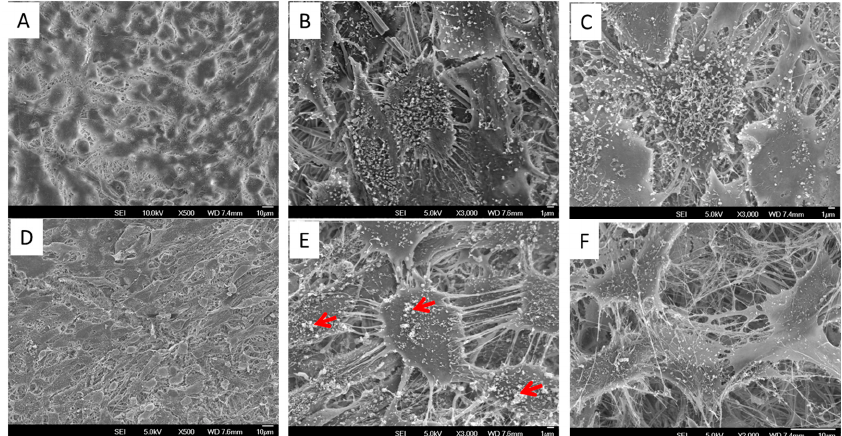
Figure 5. SEM micrographs showing mBMSCs morphologies cultured on PLLA and ECM/PLLA NF for 14 days. ( A ) PLLA (at low mag); ( B ) PLLA (at high mag); ( C ) PLLA (matrix deposition); and ( D ) ECM/PLLA (at low mag); ( E ) ECM/PLLA (at high mag); ( F ) ECM/PLLA (matrix deposition). It is